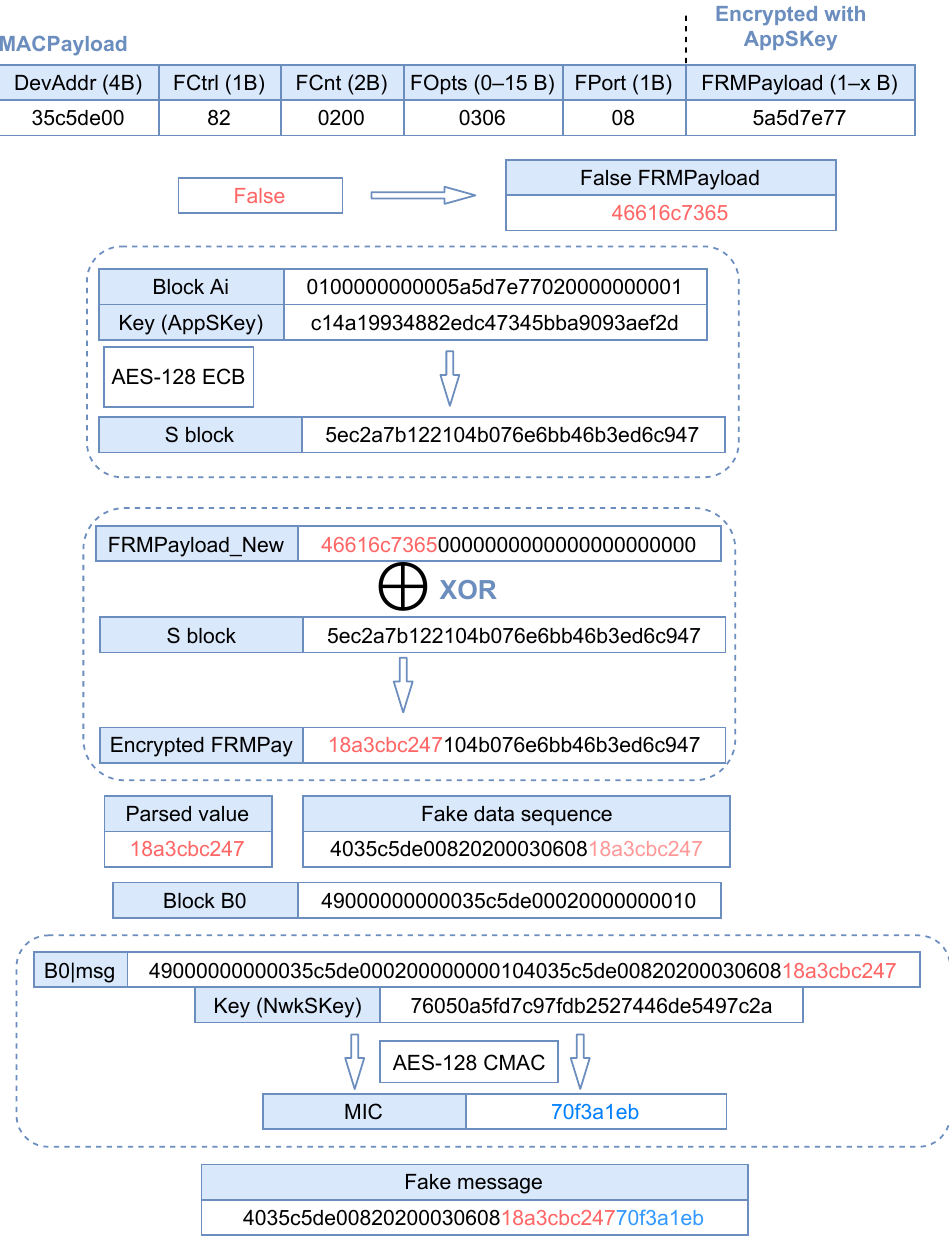
Figure 15. Bit-flipping attack: the procedure for creating a fake